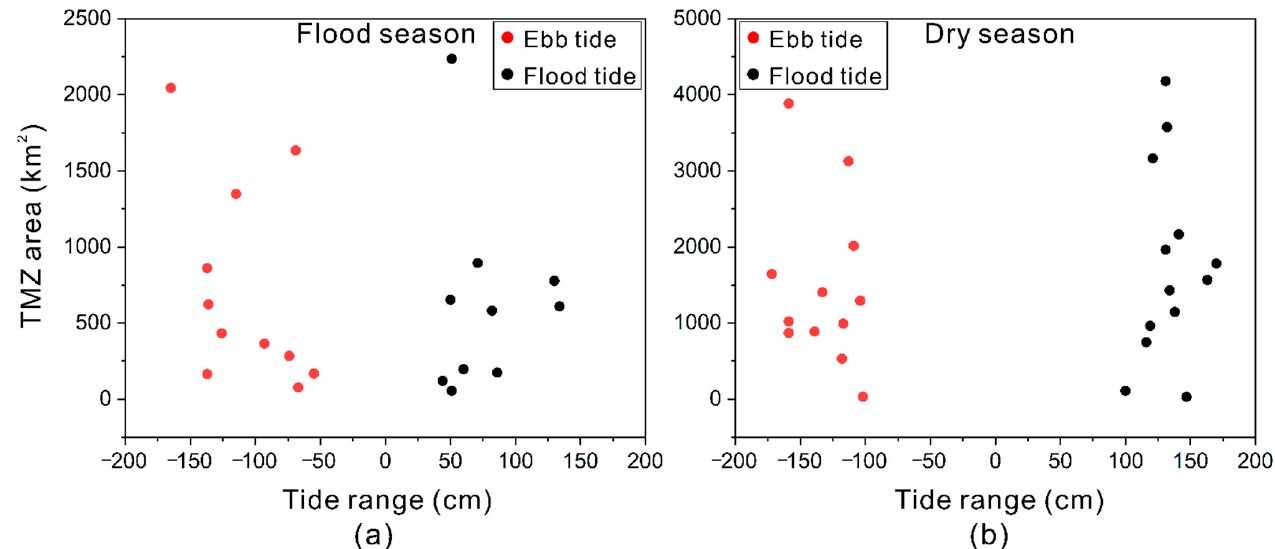
Figure 12. Relationship between tide and TMZ area. The tide range denotes the tidal difference of high tide and low tide within one tide cycle. Data in ( a ) are in flood season (summer and autumn), ( b ) were in dry season (spring and winter). The wind speed in ( a , b ) was between 4 and 5 m/s.